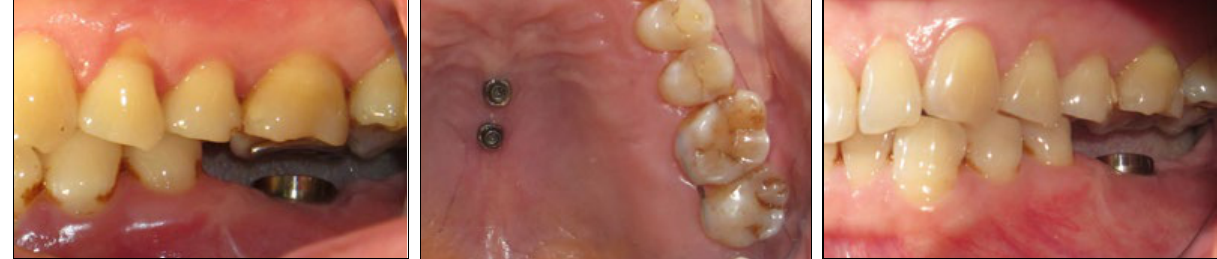
Figure 8. A 38-year-old female patient with an over- erupted upper left second molar.